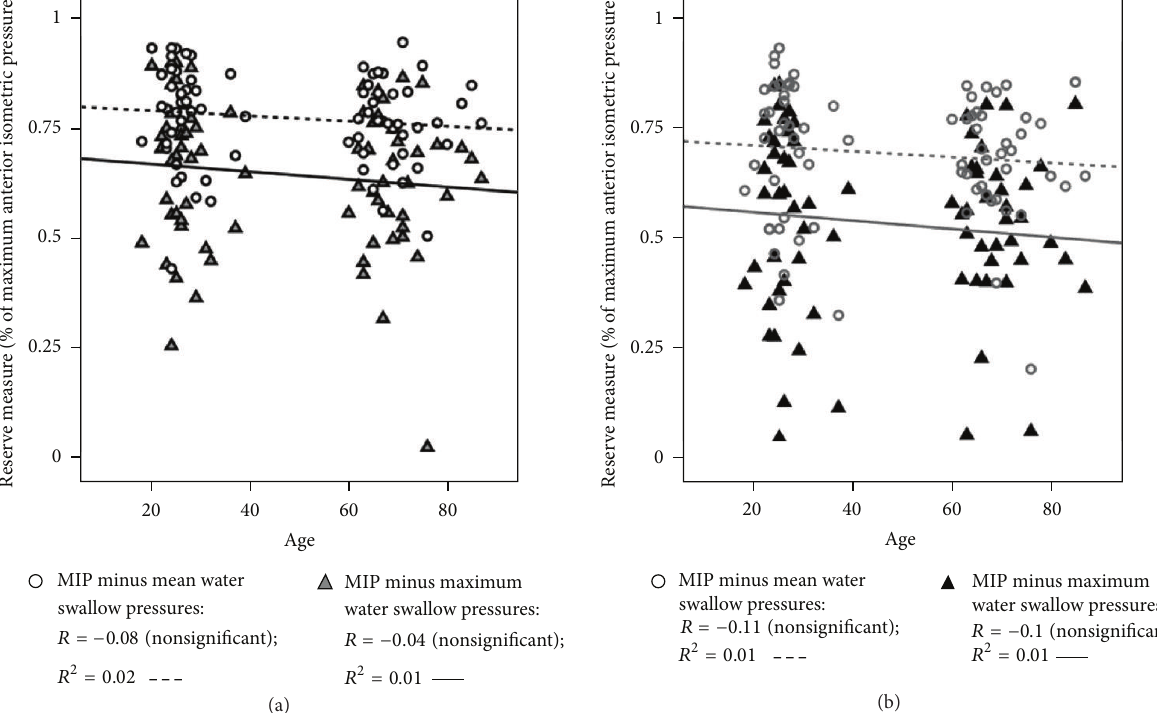
Figure 5: (a) Scatter plot showing the relationship between functional reserve measures comparing maximum isometric pressure (MIP) to water swallowing pressures and age, with swallow pressures expressed as a percentage of MIP. (b) Scatter plot showing the relationship between functional reserve measures comparing maximum isometric pressure (MIP) to regular effort saliva swallowing pressures and age, with swallow pressures expressed as a percentage of